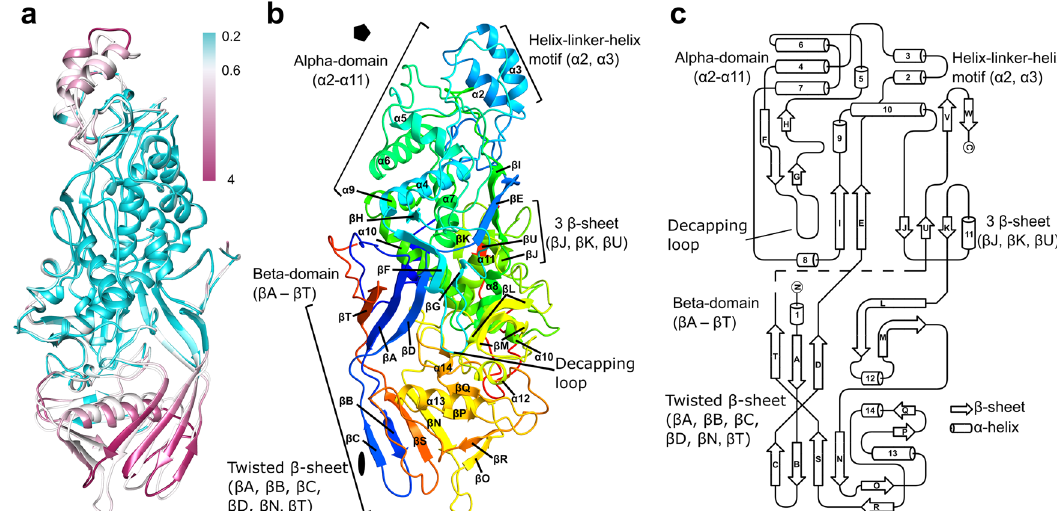
Fig. 3 Structure of L-BC capsid protein. a Comparison of structures of L-BC A and B subunits. The B subunit is colored based on the RMSD difference in the positions of atoms forming the corresponding residues of A and B subunits. The A subunit is colored the same as B, except for residues with RMSD larger than 0.6 Å, which are white. b Cartoon representation of A subunit rainbow-colored from N-terminus in blue to C-terminus in red. The secondary structure elements are labeled. The positions of twofold and fi vefold icosahedral symmetry axes are indicated with an oval and pentagon, respectively. c Two-dimensional topology representation of secondary structure elements of A subunit.